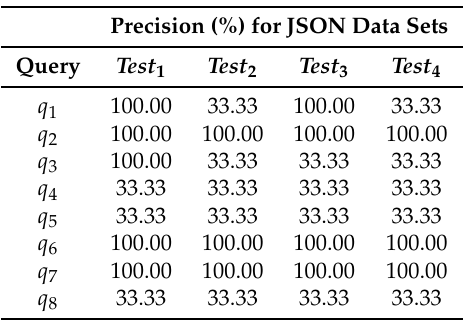
Table 1. Sensitivity Analysis for JSON Data Sets.